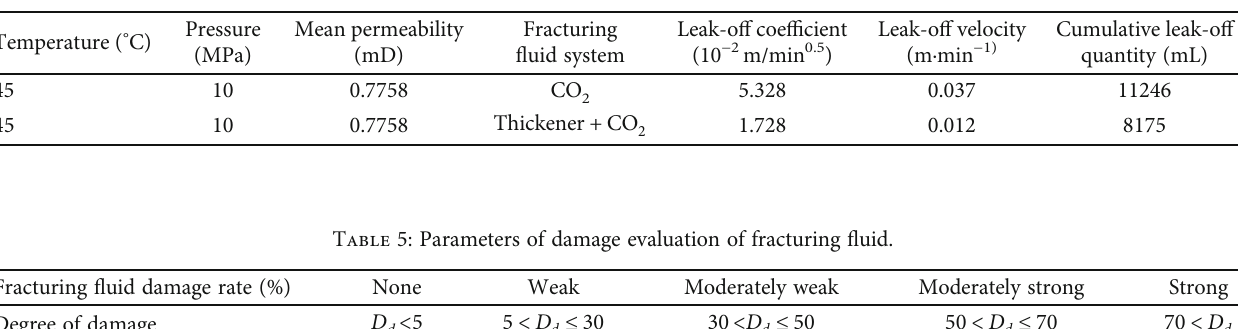
Table 6: Core damage performance of CO